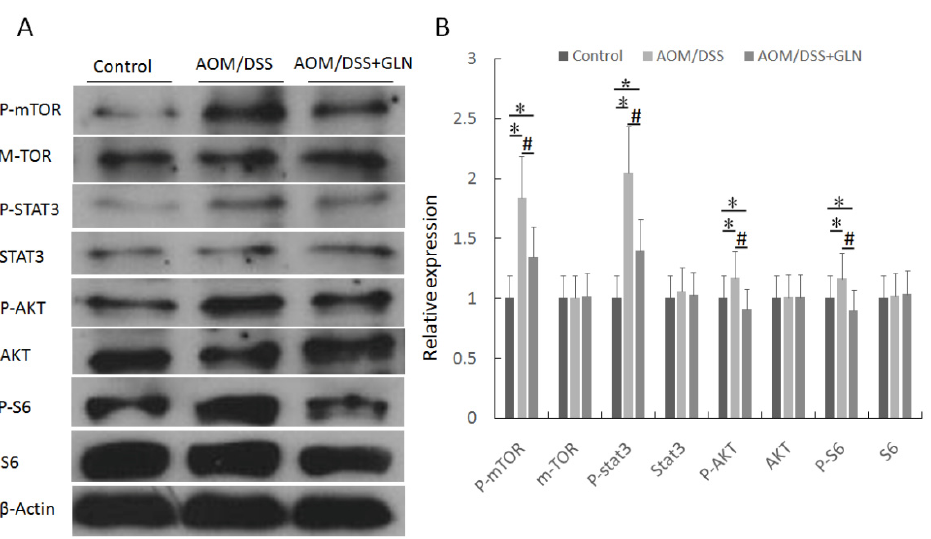
Figure 3. GLN suppresses m ‐ TOR signaling pathway in vivo . Western blot analysis of P ‐ mTOR, mTOR, P ‐ STAT3, STAT3, P ‐ AKT, AKT, P ‐ S6, and S6 in AOM/DSS mice treated with or without GLN ( A ); and the expressions were statistically analyzed relative to β‐ actin expression by densitometry ( B ). Data are expressed as the means ± SD, * p < 0.05 vs. control group, # p < 0.05 vs. AOM/DSS group.